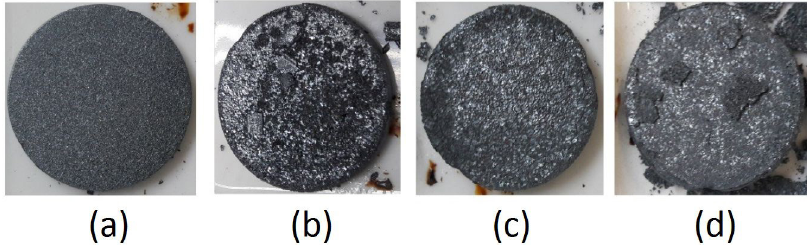
Figure 7. Photos of AISI 348 samples surfaces after 1.5 h of oxidation in water at (a) 1100 °C, (b) 1200 °C, (c) 1300 °C, and (d) 1350 °C.